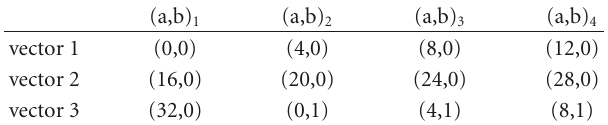
Table 4: Reading without permutation.